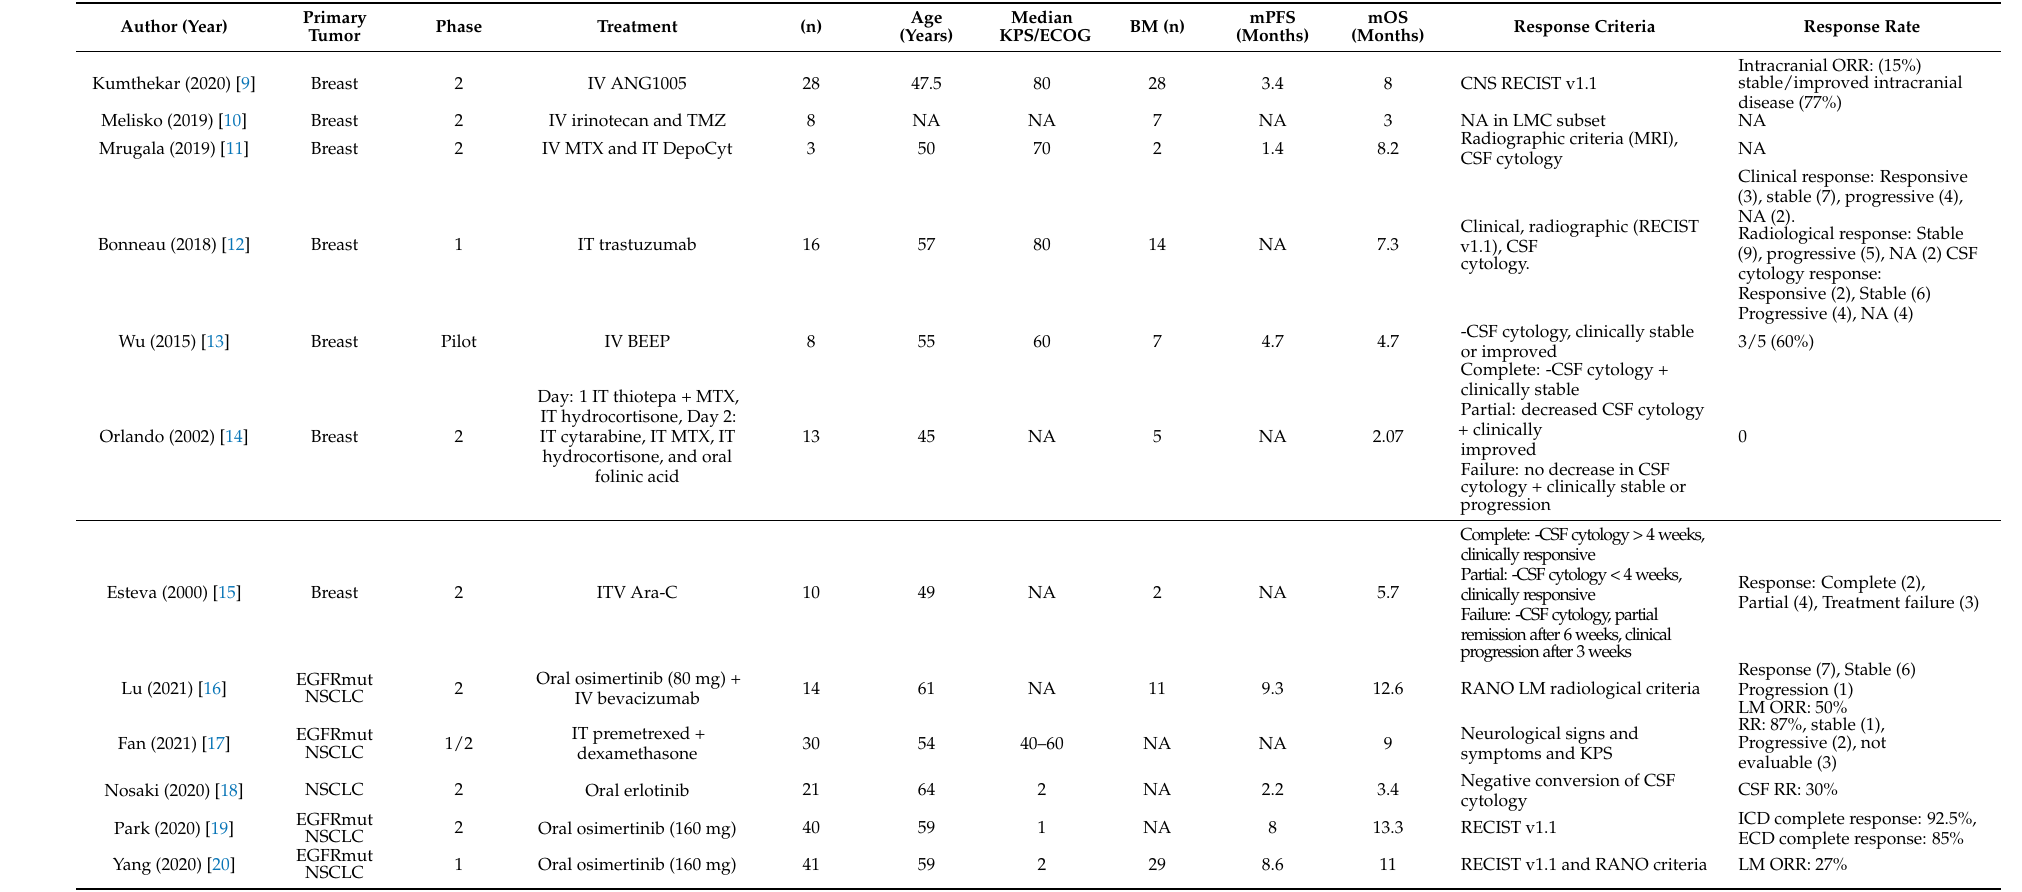
Table 1. Non-randomized clinical trials for leptomeningeal carcinomatosis from solid non-hematological